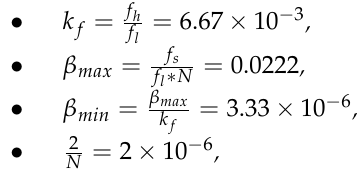
Figure 17. Overview of the HFSS model mesh.